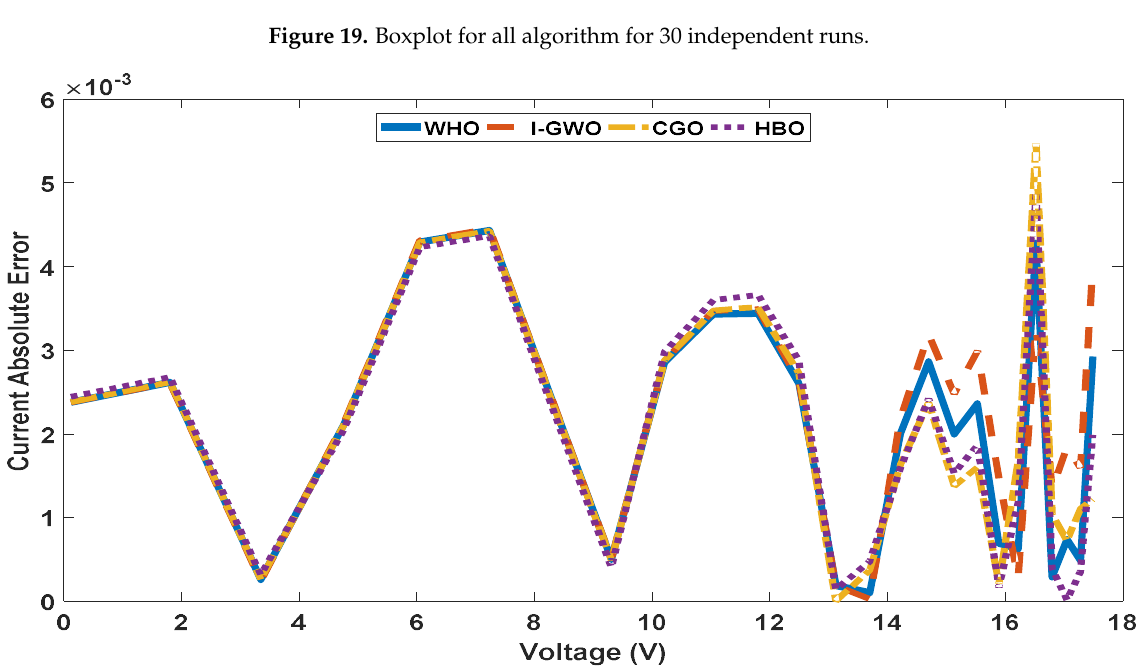
Figure 20. Current absolute error of all algorithms.